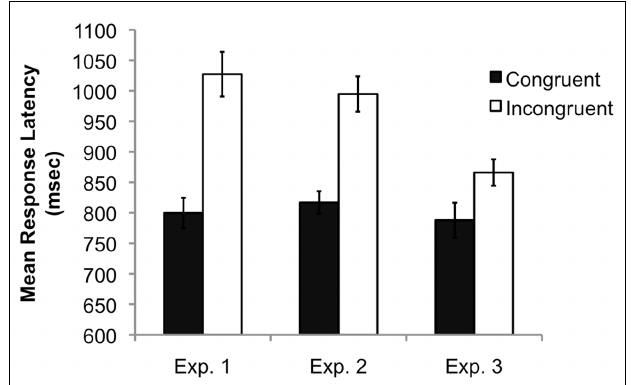
FIGURE 2 | Mean and SE response latencies for each of the two CombinationTypes (congruent, incongruent) and across all three